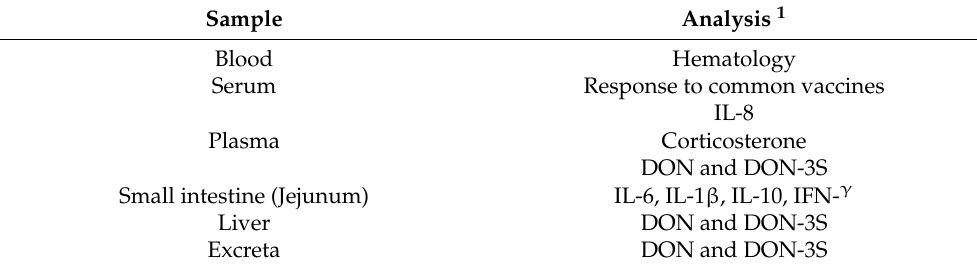
Table 2. Collection of biological